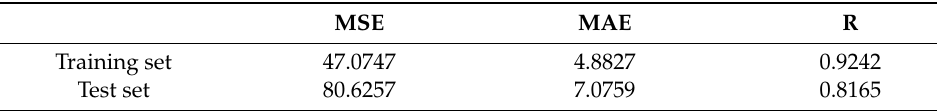
Table 8. Evaluation metrics for training set and test